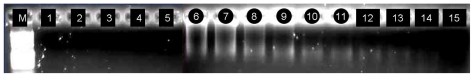
A 1.1% agarose gel electrophoresis of size-fractionated cDNA for removal of small oligonucleotides. Single-drop fractions (15 fractions, 35 μL each) were collected in separated tubes, and 3 μL of each fraction was electrophorised on 1.1% agarose gel at 150 V for 10 min. The lightest lanes (circled numbers 6–11) indicating cDNA peaks were collected for ligationstep. M: HyberLadder marker; Lanes 1–15 are cDNA size-fractionated samples.